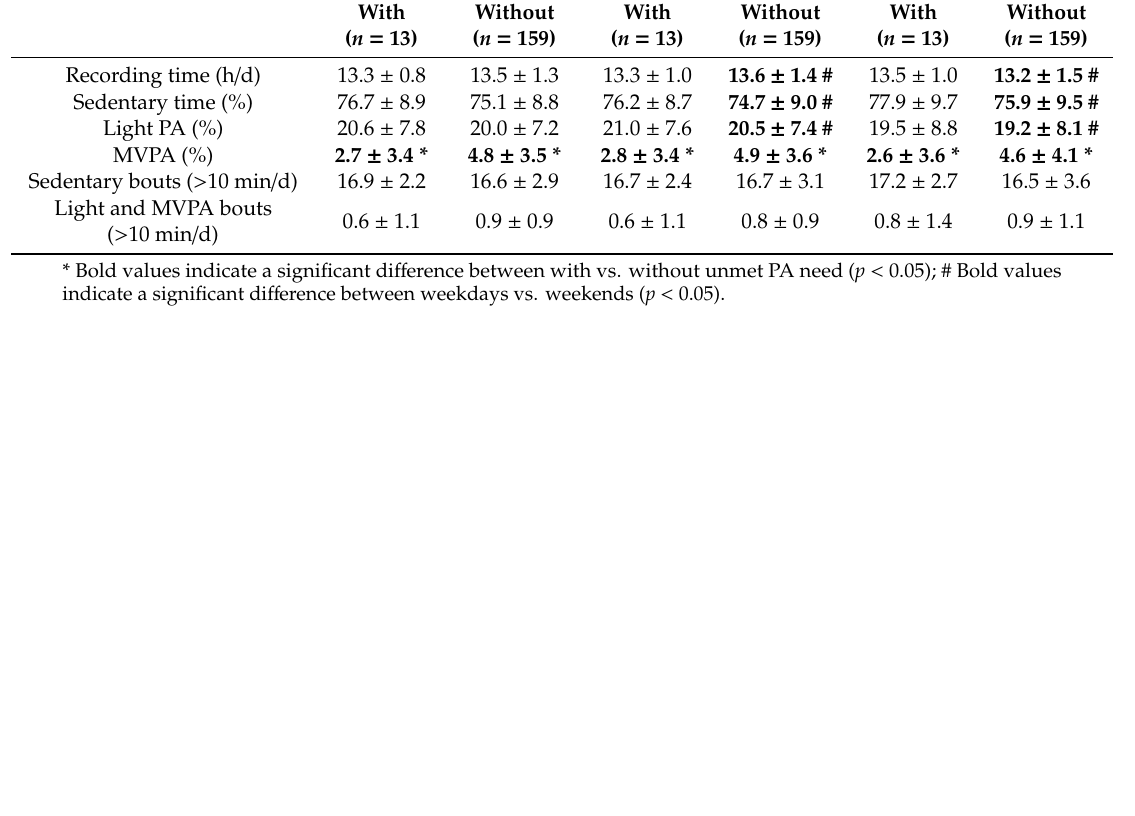
Table 2. Accelerometer-derived variables for those with unmet PA need and without unmet PA need during weekdays and weekends.